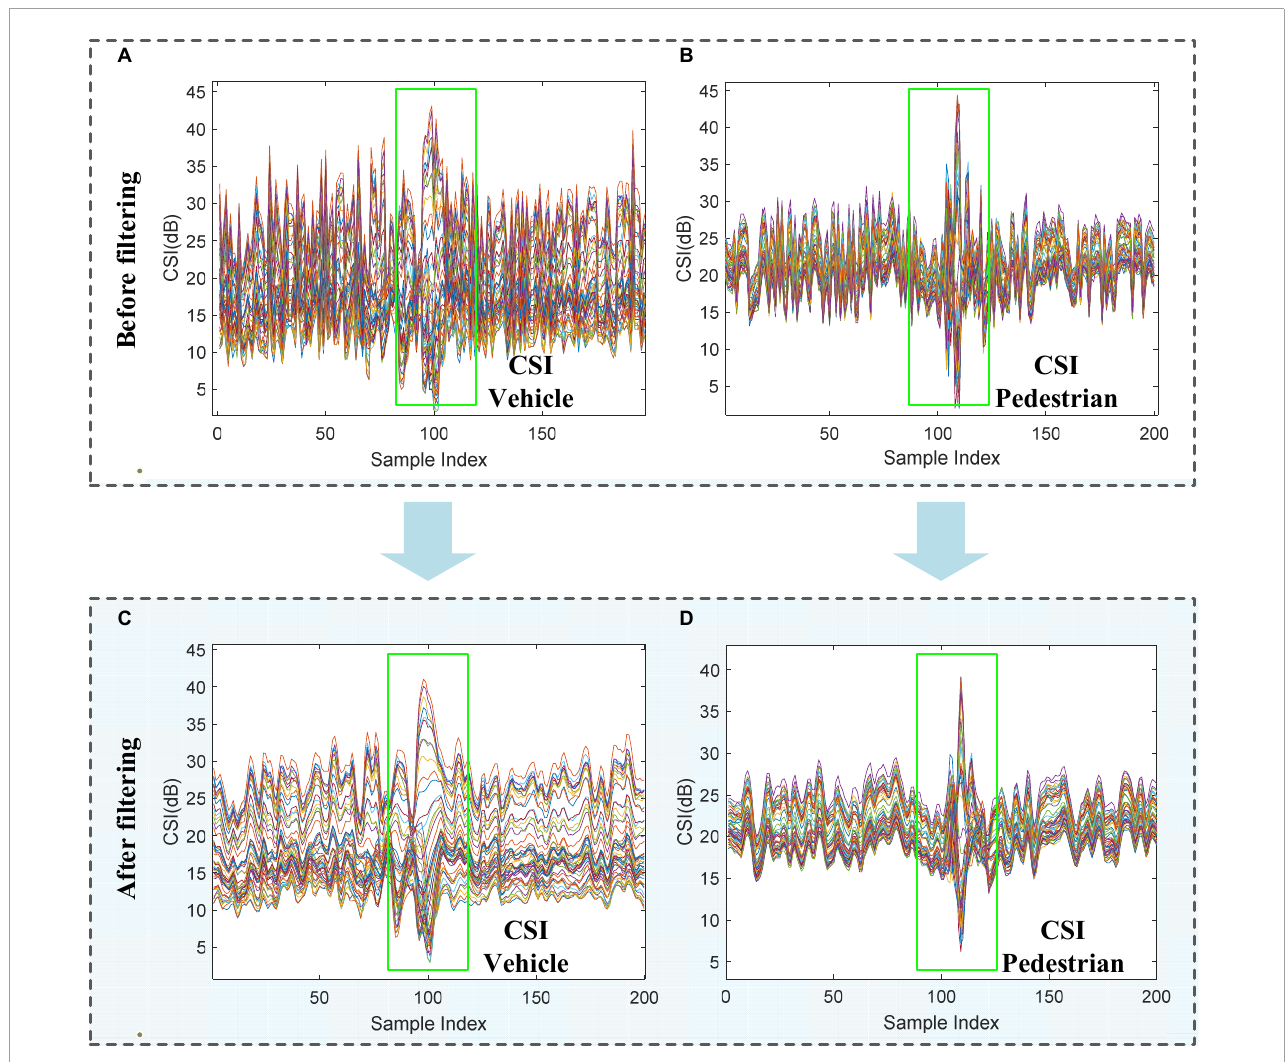
FIGURE4 Raw CSI waveform vs. filtered waveform. (A) The raw CSI waveform of the vehicle. (B) The raw CSI waveform of the pedestrian. (C) The filtered CSI waveform of the vehicle. (D) The filtered CSI waveform of the